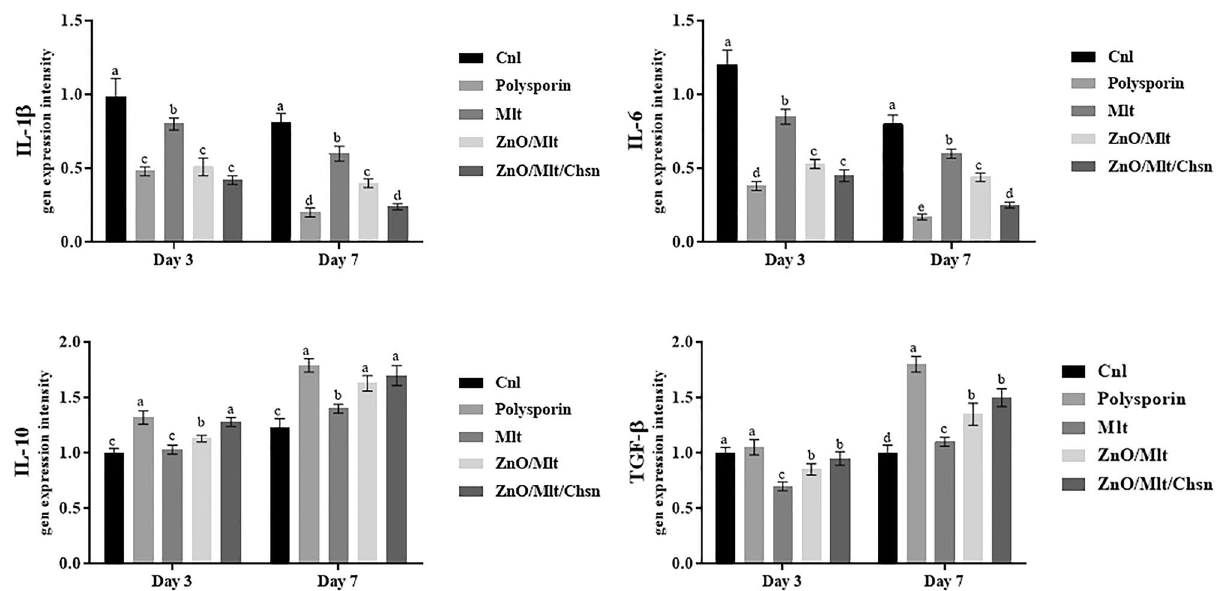
Figure 13. Relative IL-1β, IL-6, IL-10, and TGF-β mRNA expressions were measured by qRT-PCR using the 2_ ΔΔCt method and b-actin as an internal control. The administration of ointments based on malachite reduced the expression of IL-1β and IL-6 compared to the control group. The administration of ZnO/Mlt and ZnO/Mlt/ Chn ointments increased the expression of IL-10 on days 3 and 7 and TGF-β on day 7 compared to the control group. The lowest expression for IL-1β and the highest expression for IL-10 were observed in the mice treated with ZnO/Mlt/Chsn ointment and antibiotic. All data are presented in the mean ± SD. The different letters above each column indicate a difference in level ( P < 0.05 ) per sampling